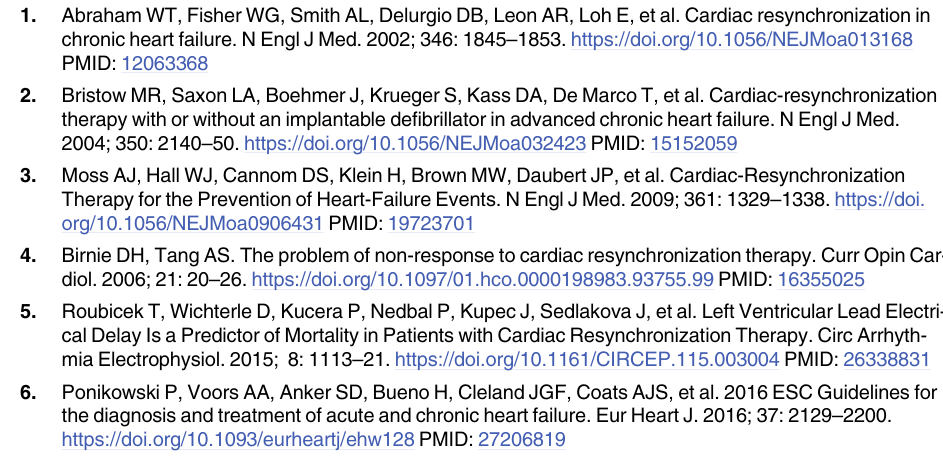
S1 Table. Comparison of baseline and 12-month characteristics in subgroups according to clinical events (hospitalization and death due to heart failure). The values are percentage or mean ± standard deviation. NS = not significant; for other abbreviations see the Table 1. S2 Table. Comparison of baseline and 12-month characteristics in subgroups according to clinical events (cardiac and all-cause death). The values are percentage or mean ± standard deviation. NS = not significant; for other abbreviations see the Table